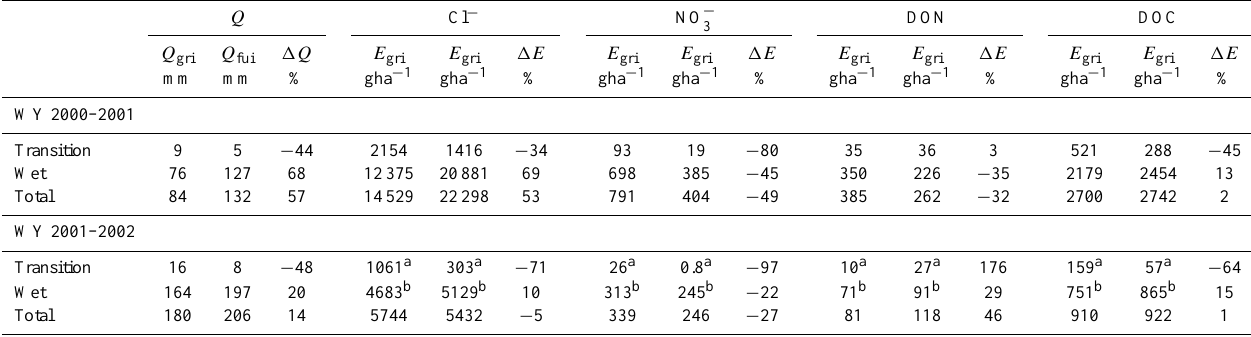
Table 2. Cumulative water ( Q ) and solute export ( E i ) from the hillslope (gri) and valley-bottom (fui) catchments during the transition and wet periods for the study period. The relative difference in stream water ( 1Q ) and solute ( 1E i ) export between the two catchments is shown in each